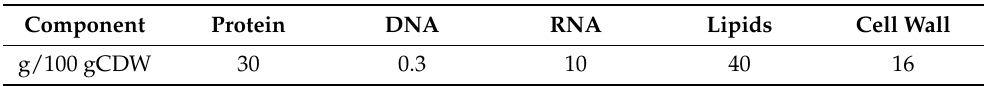
Table 1. Macromolecular composition of U. maydis calculated by linear optimization. The full composition is provided as a